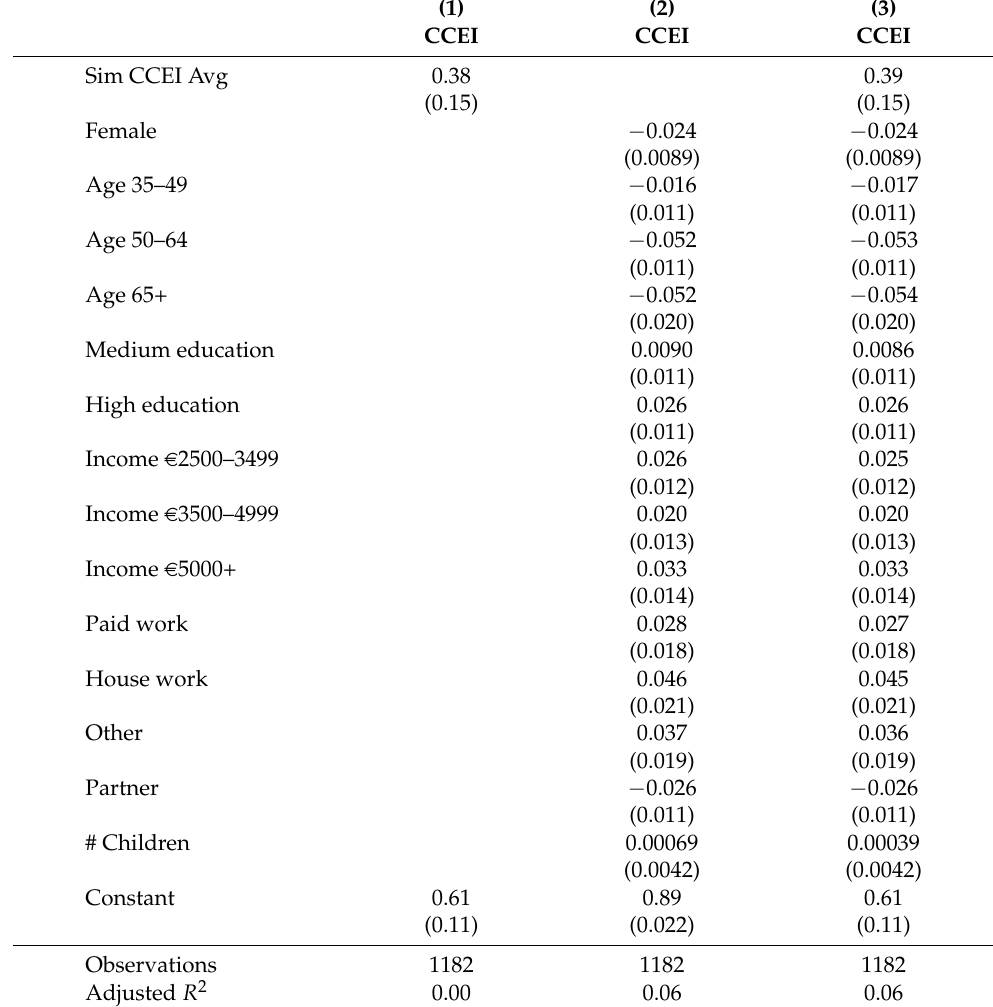
Table 1. Regressions with